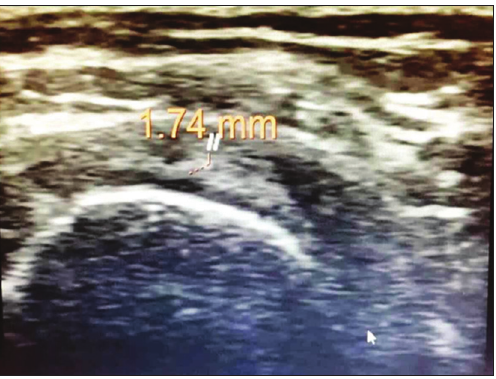
FIGURE 2. Post-treatment musculoskeletal ultrasound image of coracohumeral ligament calcification size.